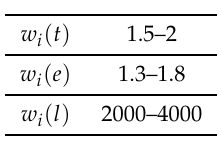
Table 7. Range of weights.